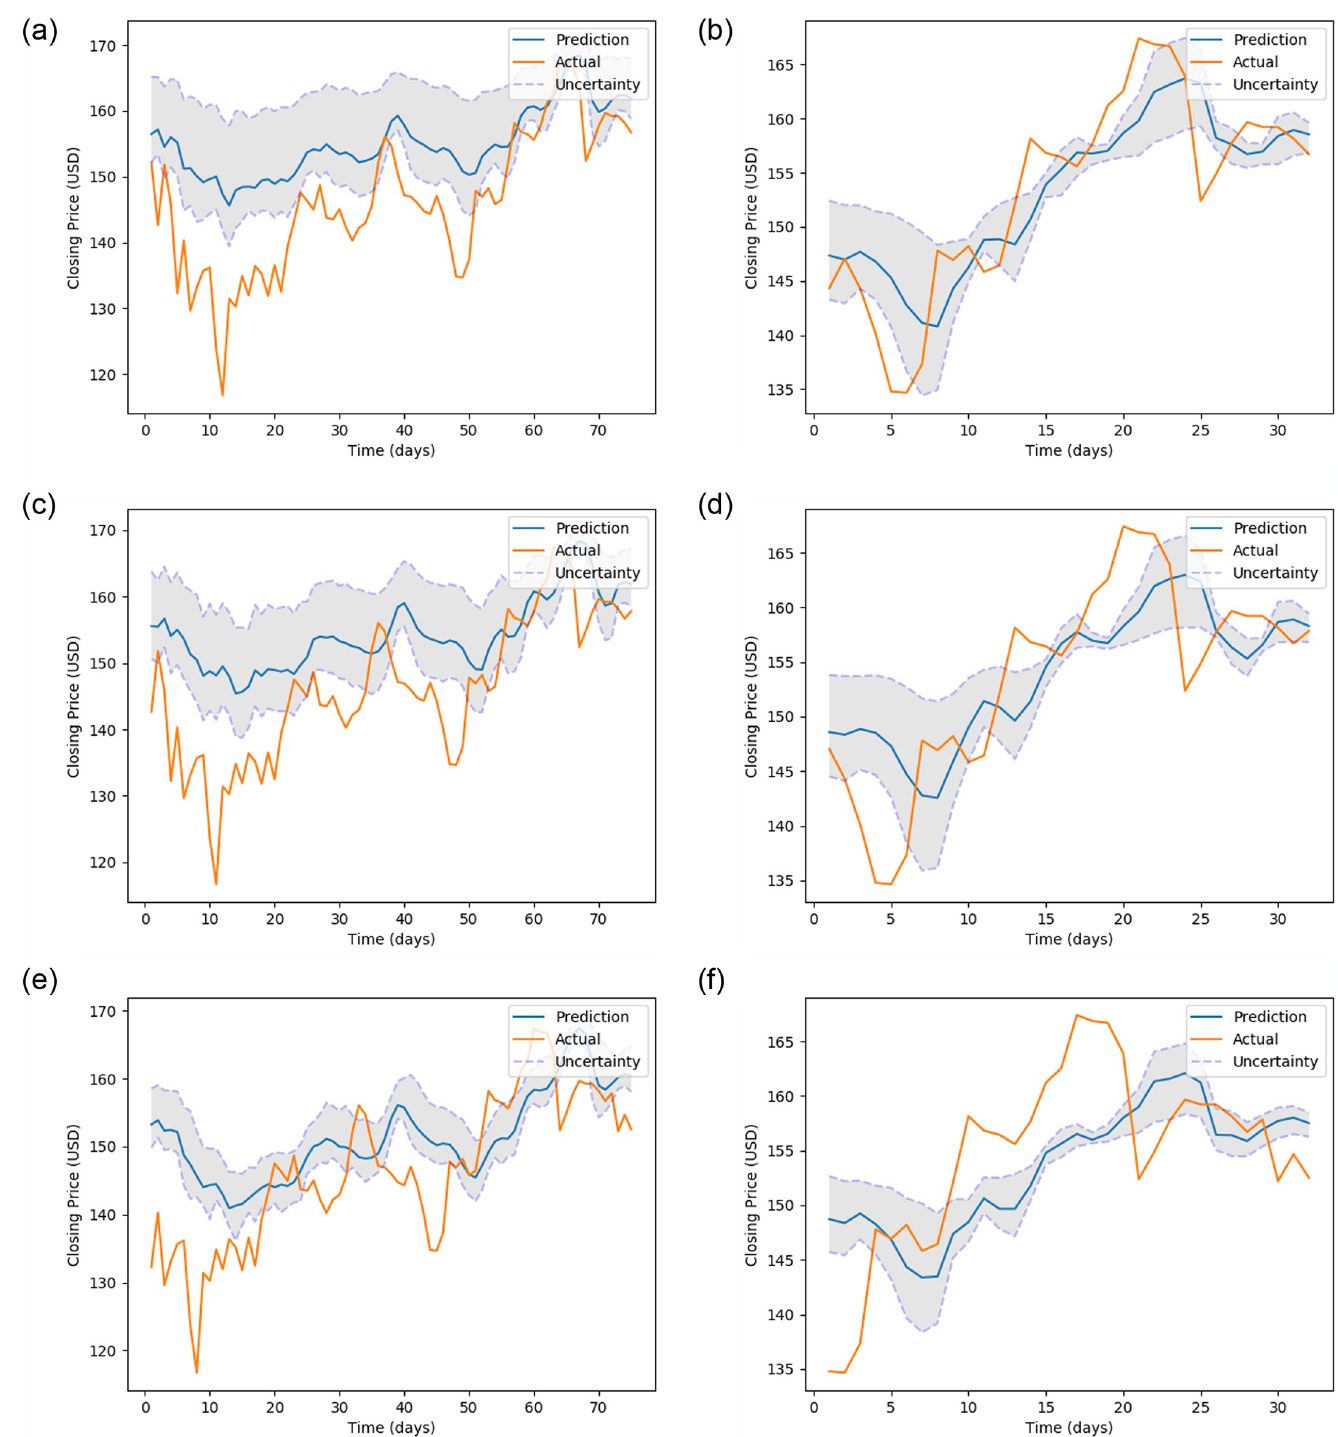
Fig 10. Prediction and uncertainty over test data of MMM (data setup 1 vs data setup 2).